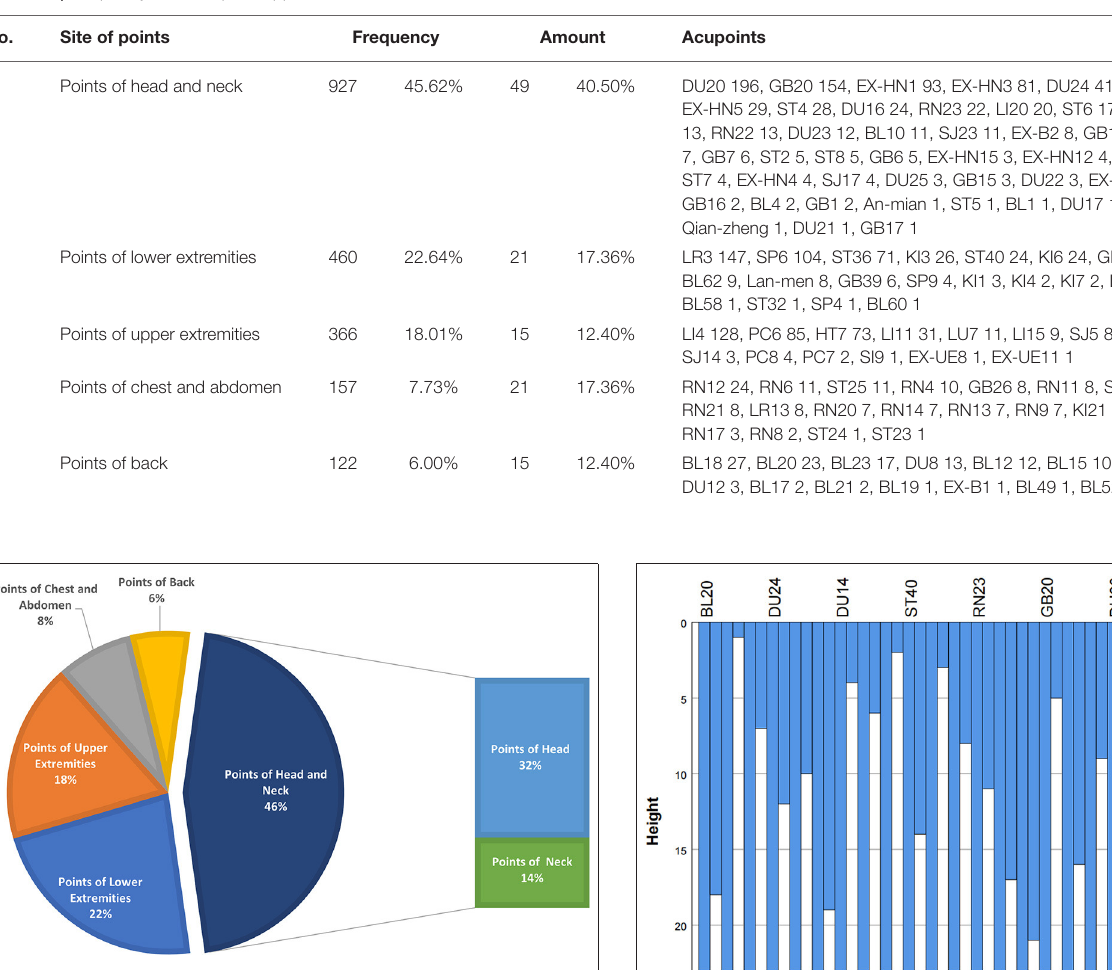
TABLE 4 | Frequency of site of point application for TD treatment.